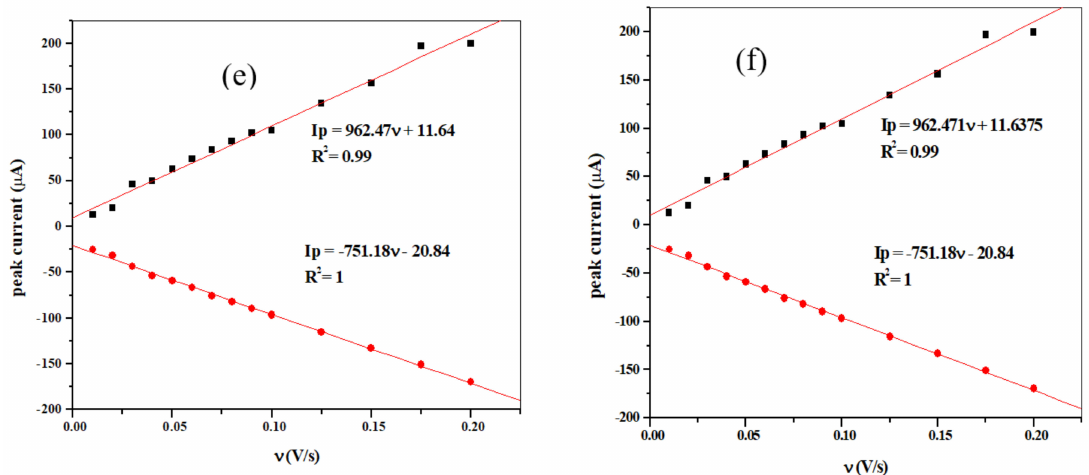
Figure 12. The plot of Ip (current) versus square root of scan rate ( a – c ) and Ip (current) versus of scan rate. ( d – f ) for the SPCE / LPE ZnO NPs, SPCE / GPE / ZnO NPs and SPCE / OPE / ZnO NPs respectively in 10 mM K 3 [Fe(CN) 6 ] prepared in 0.1 M KCl at pH ≈